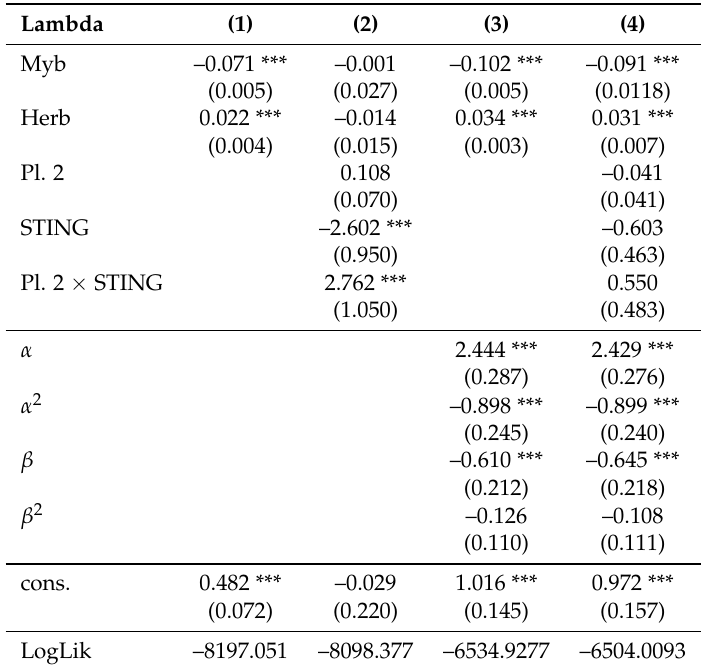
Figure 3. Individual estimates of α and β . ( a ) plots the individual estimated ( α , β ) pair; ( b ) reports the corresponding 95% confidence intervals associated to each individual estimated parameter pair. Table 1. Structural